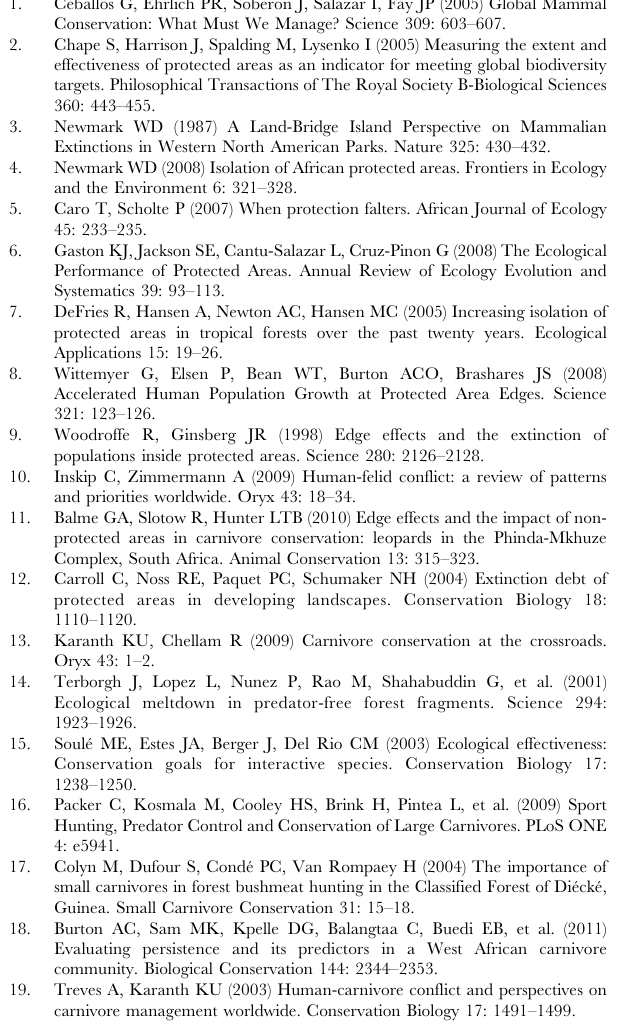
code for the hierarchical multi-species carnivore occur- rence